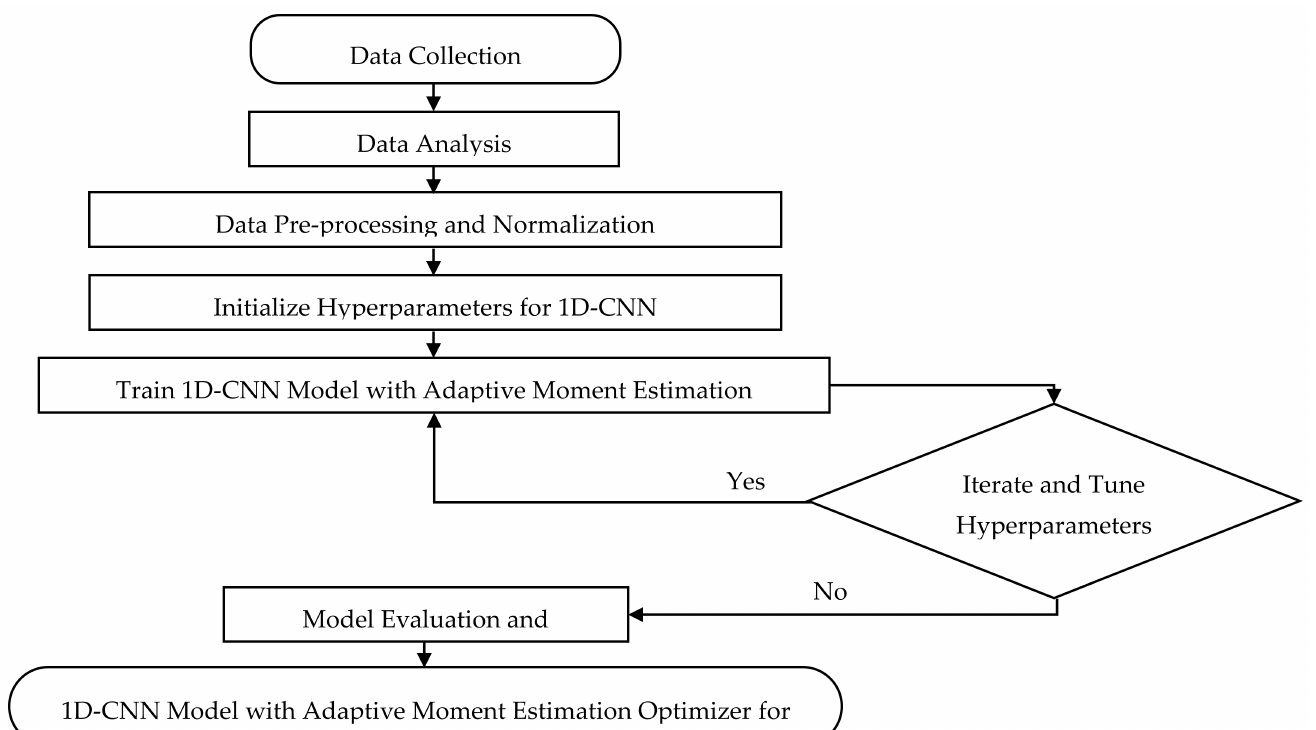
Figure 2. One-dimensional convolutional neural network (1D-CNN) model development